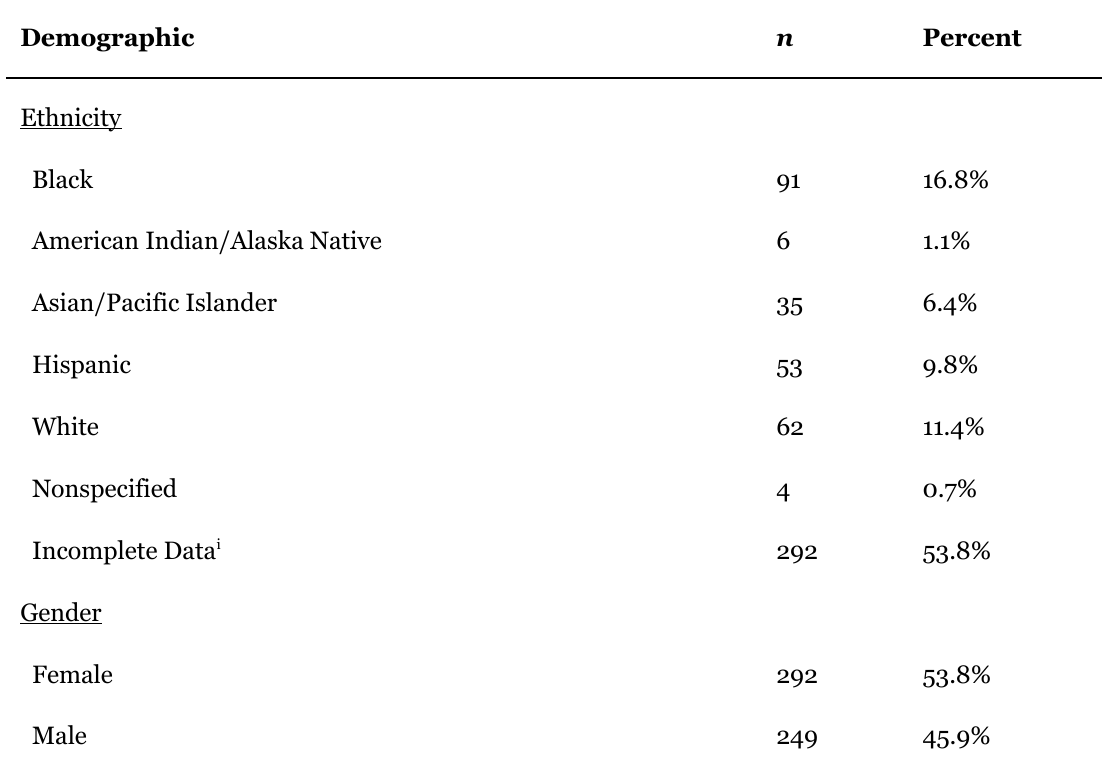
Student Demographic Descriptives